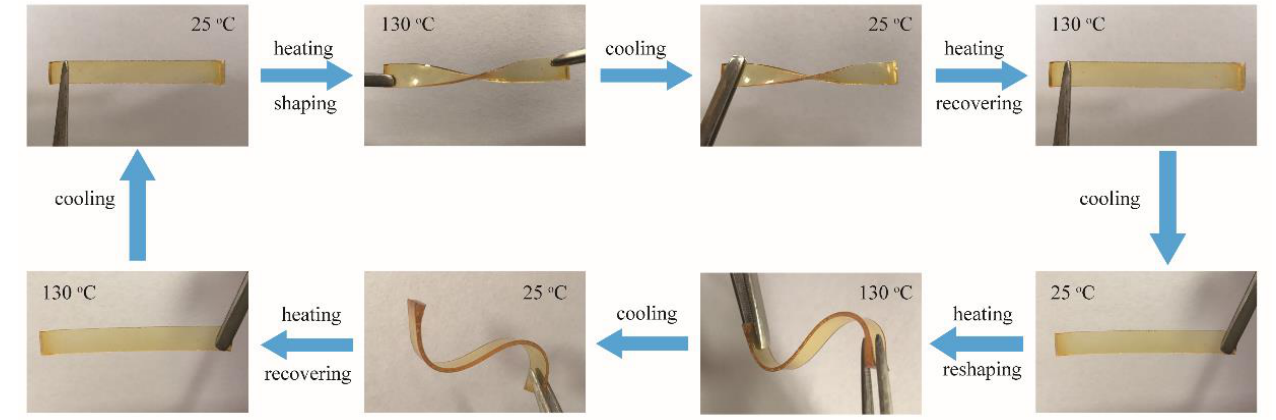
Figure 10. Optical microscope images of shape-memory performance of the 20% C-FPAE sample.